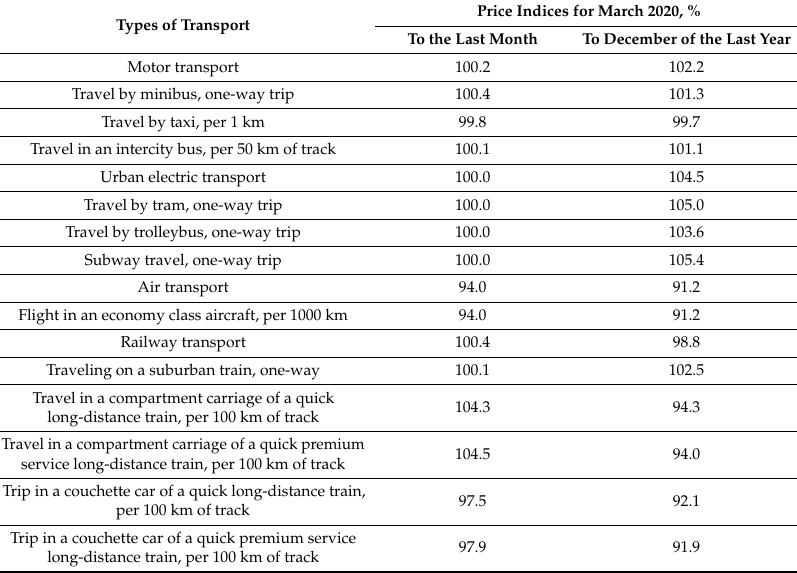
Table 3. Tariff indices for passenger transport services in March 2020 [69]. Table 3. Tari ff indices for passenger transport services in March 2020